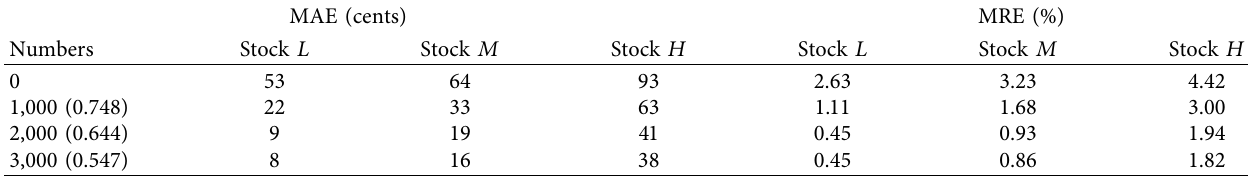
Table 16: Impact of hedgers on price efficiency in the spot market.